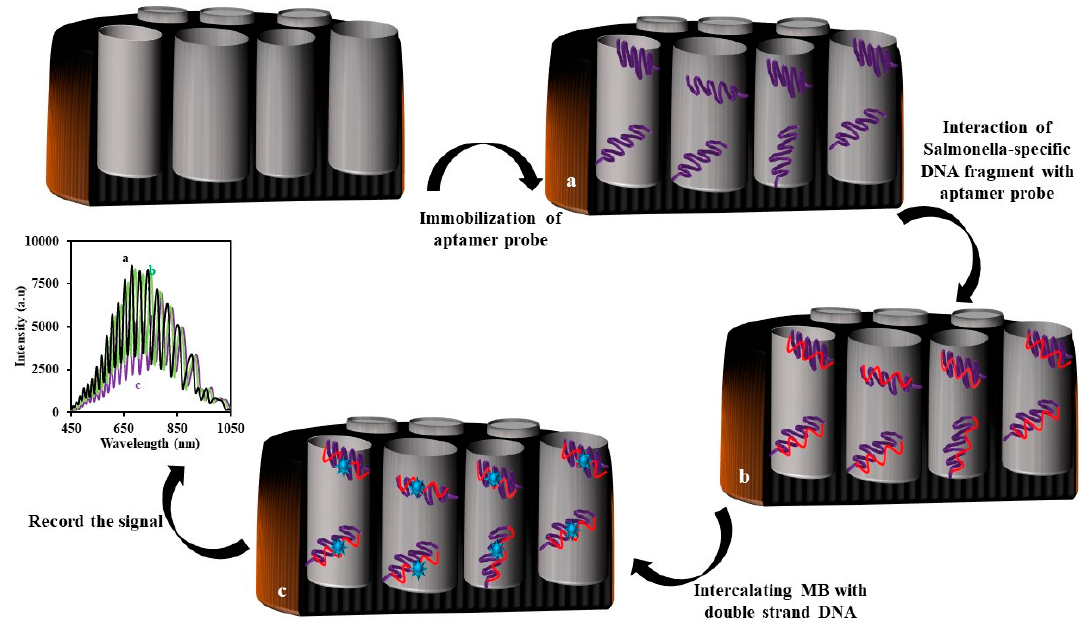
Figure 10. Schematic representation of the genosensor for the determination of a Salmonella-specific DNA fragment using IRS. DNA fragment using